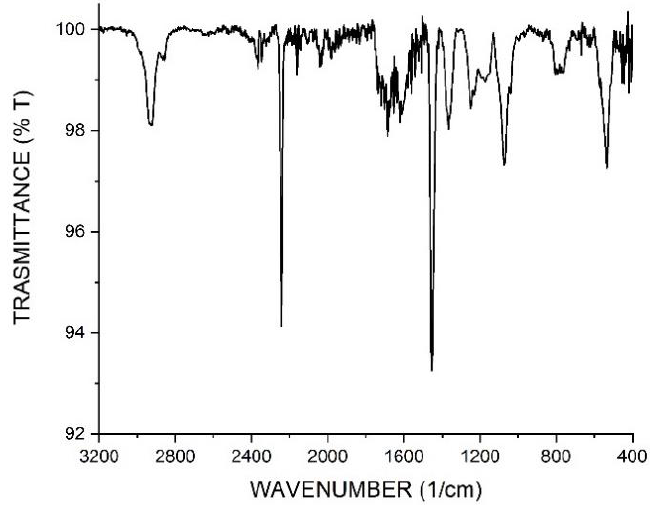
Figure 6. FTIR analysis of PAN-PMMA electrospun membrane.